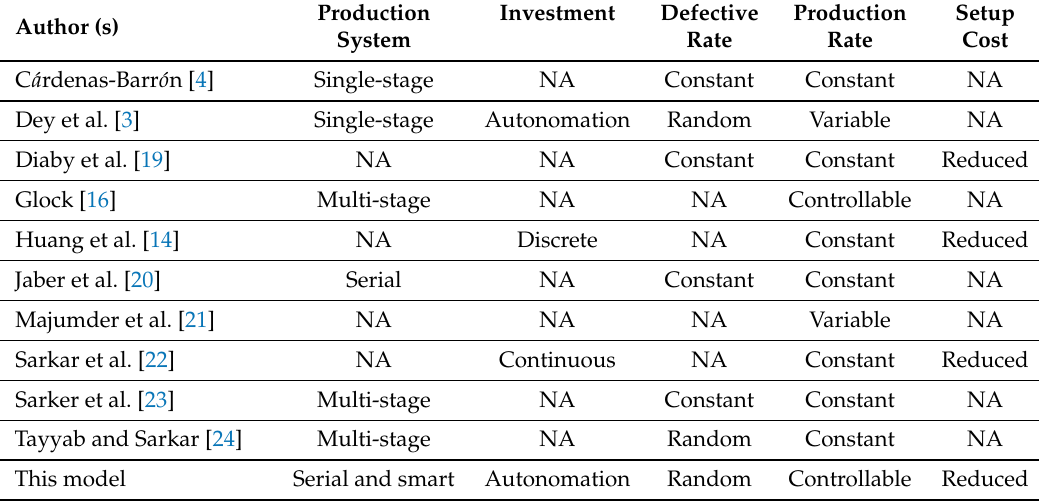
Table 1. Contribution of previous